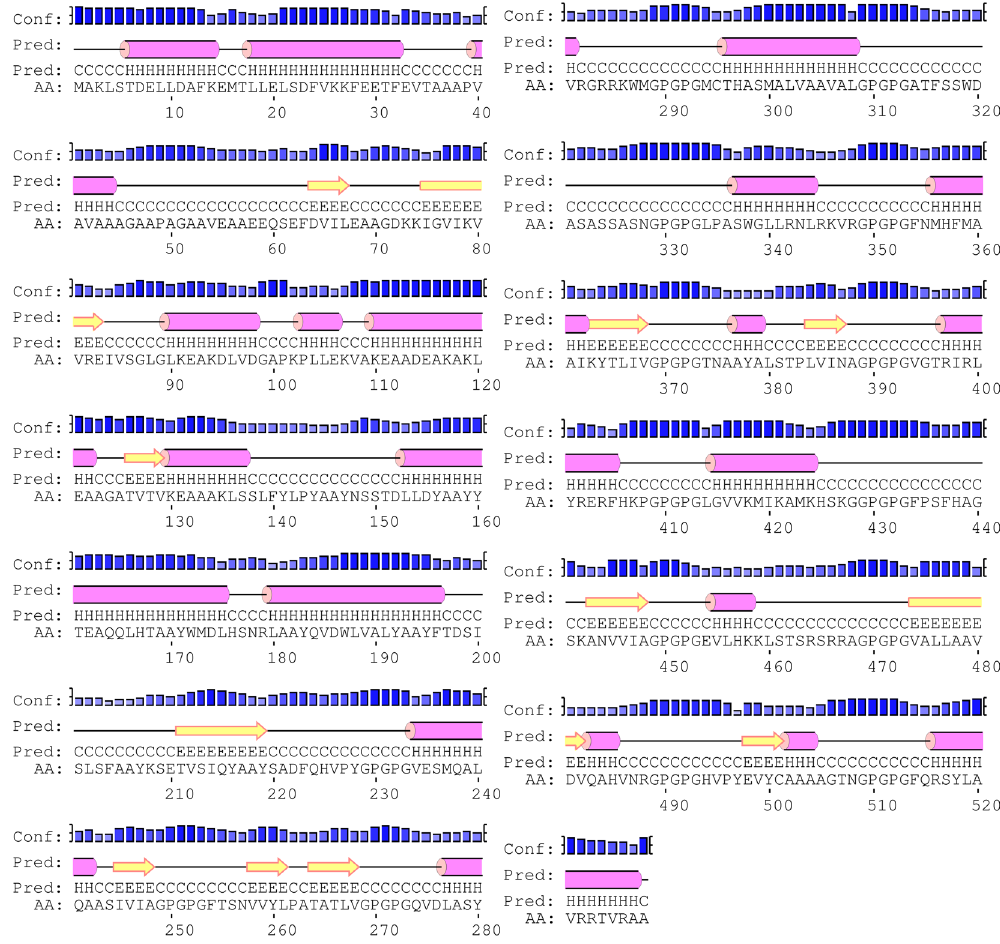
Figure 3. Graphical representation of secondary structure obtained for the final subunit vaccine construct showing alpha-helix (35.8%), beta strands (12.9%) and coils